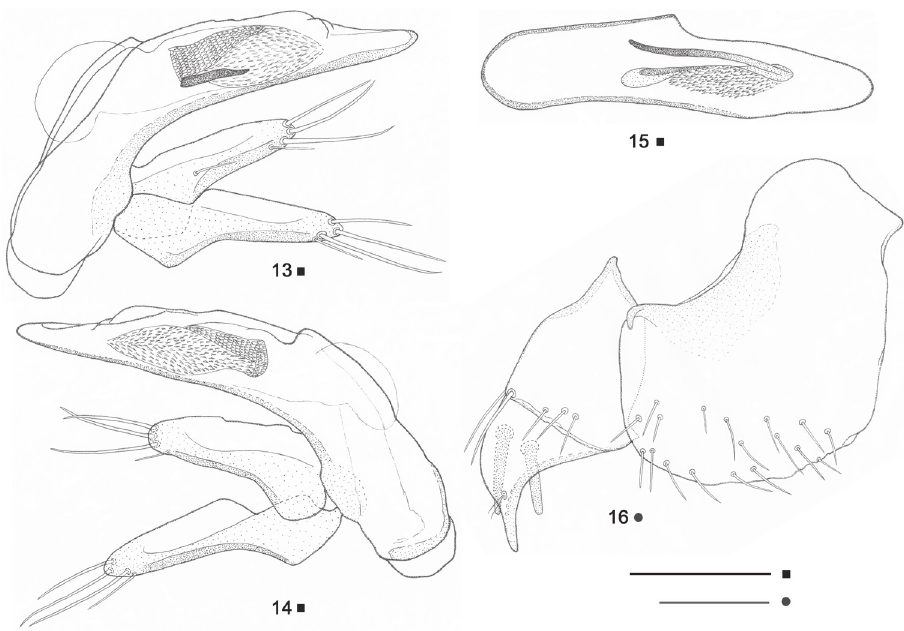
Figures 13–16. 13 Beronaphaenops gen. n. paphlagonicus sp. n. Aedeagus in left lateral aspect, holotype. 14 Aedeagus in right lateral aspect, holotype 15 Aedeagus in dorsal aspect, holotype 16 Left ovipositor in ventral aspect, paratype ♀ . Scale bar 13, 14, 15 : 0.2 mm; 16 : 0.1